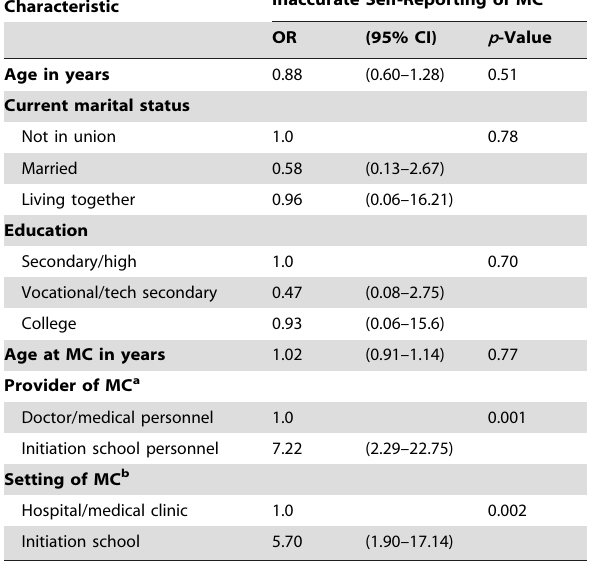
Results of simple logistic regression analysis. a Excludes participants who reported religious leader ( n =1) or other ( n =1) as provider of MC. b Excludes participants who reported home as setting of MC ( n